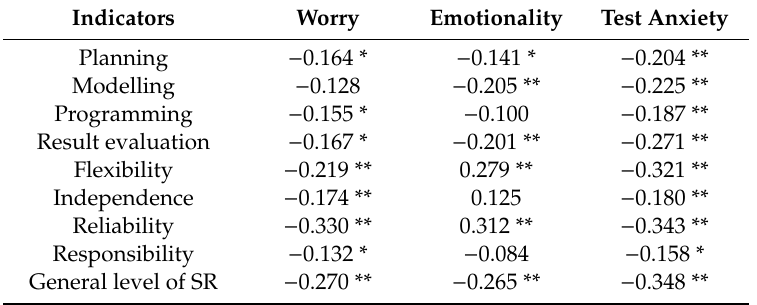
Table 3. The correlation coe ffi cients for the indicators of self-regulation and test anxiety (N = 231). Indicators Worry Emotionality